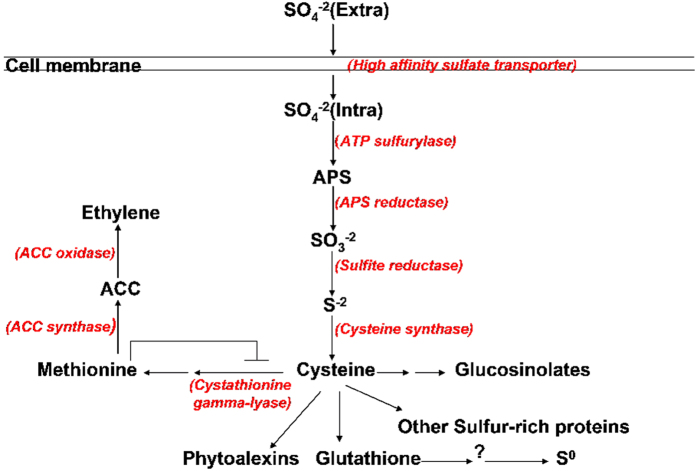
Sulfur metabolism in plants.The schematic flow diagram for sulfur metabolism, according to reviews by Thomas Rausch and Andreas Wachter11, and Kazu ki Saito21. ACC: 1-aminocyclopropane-1-carboxylate; APS: adenosine 5′- phosphosulfate; the arrow indicates induction (derepression); and the bar indicates inhibition (repression). The words in red indicate the genes encoding the enzymes (proteins) that were un-regulated in the roots of tomatoes infected by V. dahliae in tomato/potato onion companion cropping in the present study.